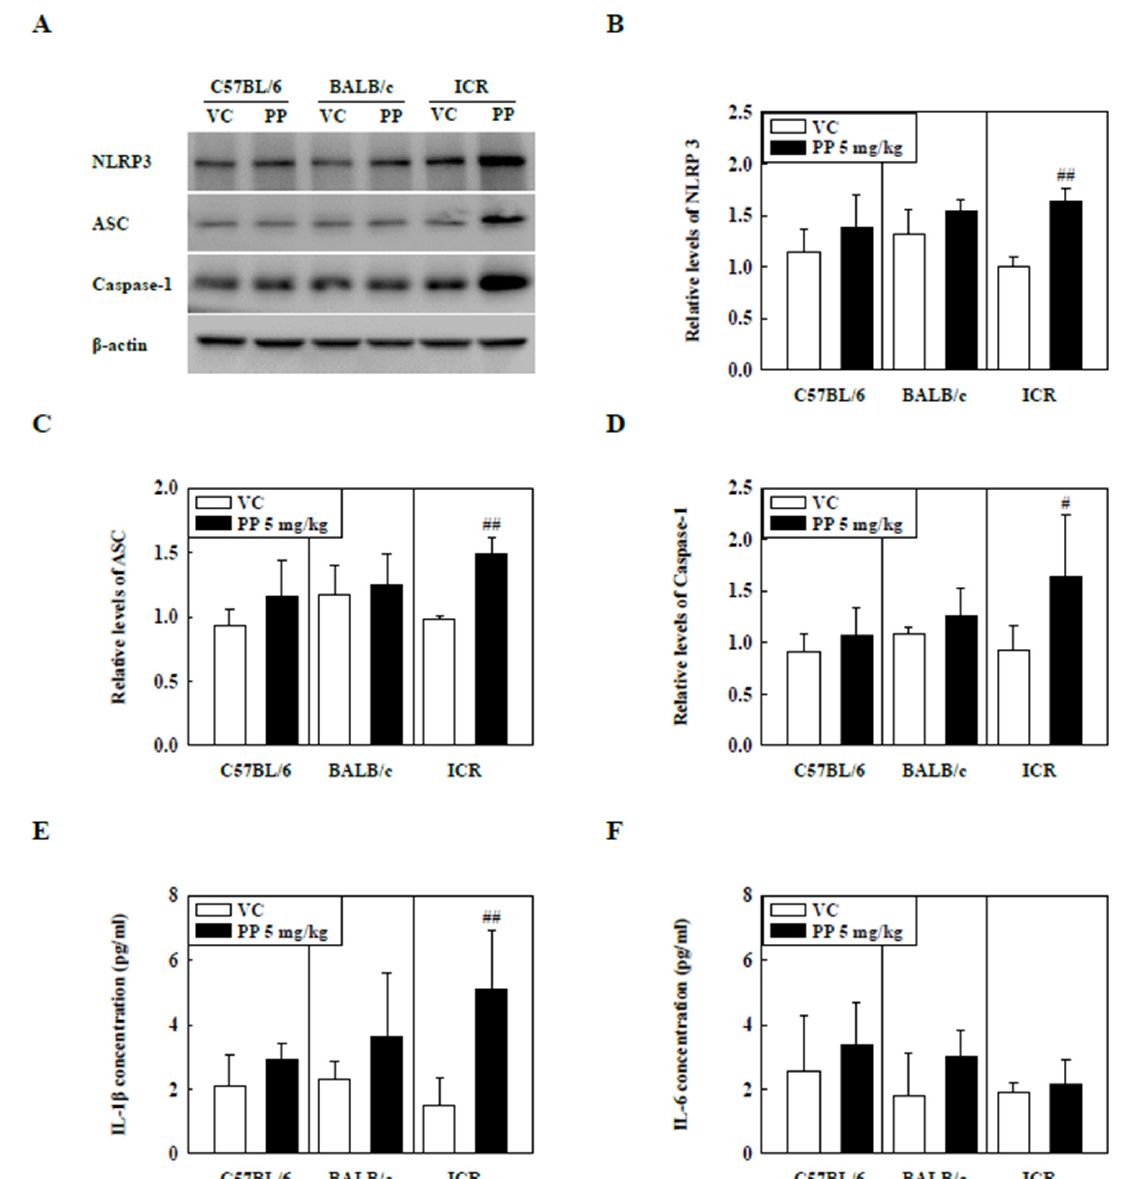
Figure 4. ( A ) Representative Western blot images of NLRP3, ASC, and Caspase-1 expression in lung tissue of three strains of PP-instilled mice. ( B ) Relative density analysis of NLRP3 levels. ( C ) Relative density analysis of ASC levels. ( D ) Relative density analysis of Caspase-1 levels. Data were normalized against β -actin. Inflammatory cytokine levels, including ( E ) IL-1 β and ( F ) IL-6, in the BALF of three strains of PP-instilled mice. Data are represented as mean ± SD (n = 5 per group). # p ≤ 0.05; ## p ≤ 0.01 vs. VC.